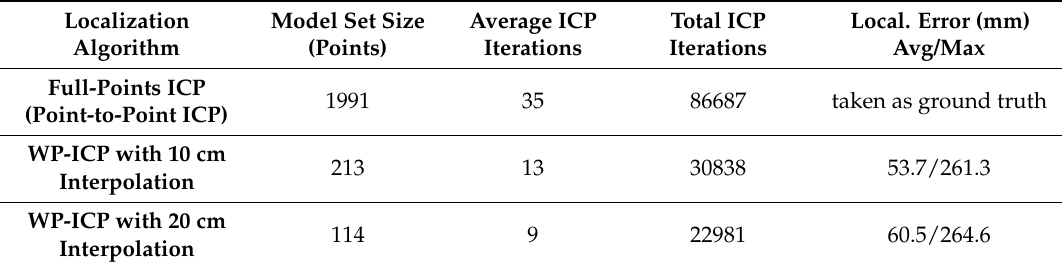
Figure 24. Localization results and ICP iterations. Table 2. Localization results for the environment subject to unknown moving objects.